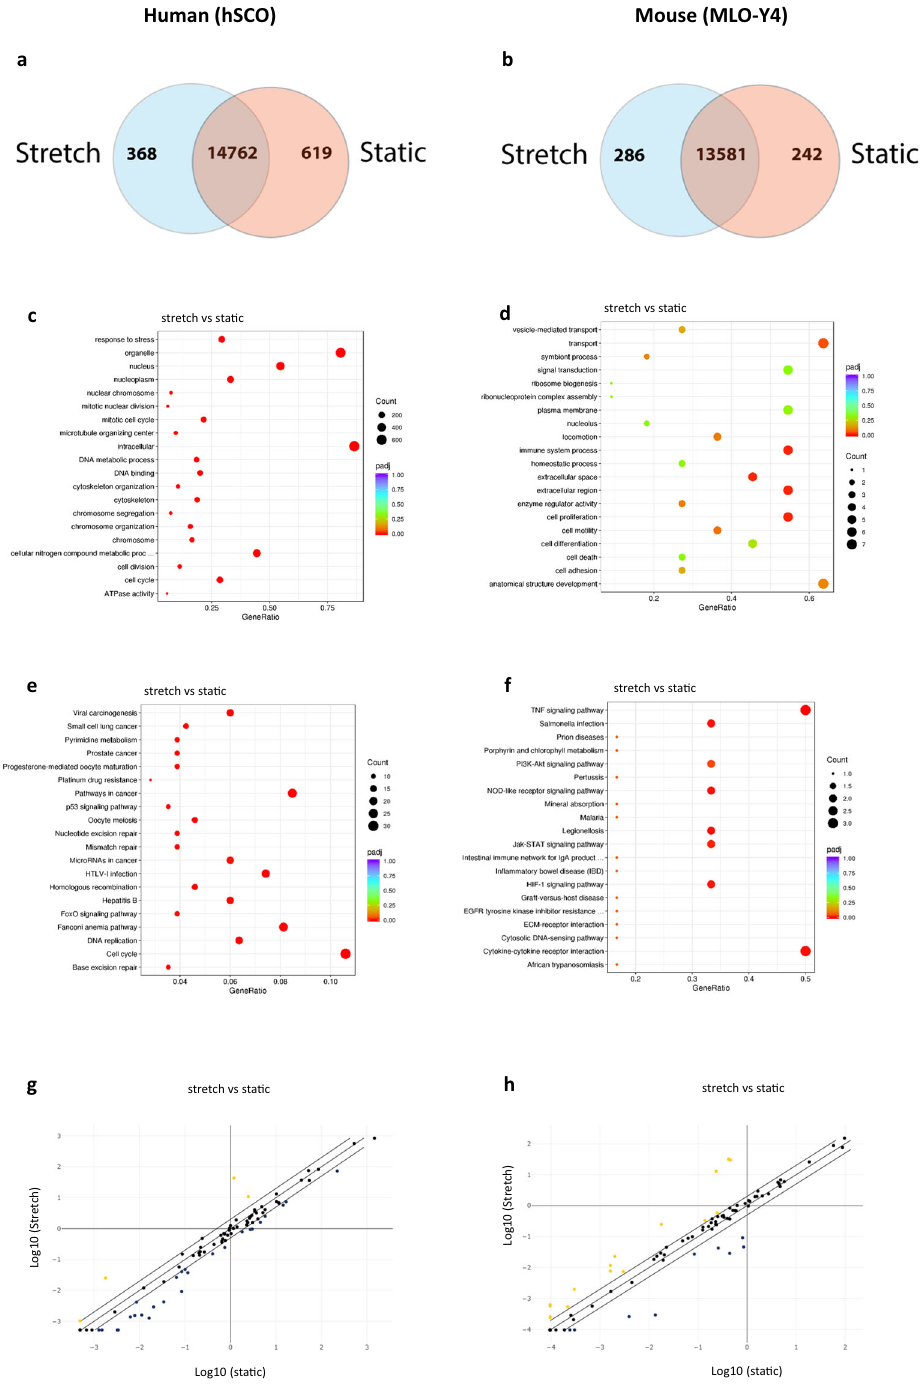
Fig. 1 Transcriptome analysis and WNT signalling in murine and human osteocytic cells. Venn diagram of hSCO ( a ) and MLO-Y4 ( b ) showing the gene transcripts exclusive to mechanically active and static cell culture conditions; Chart depicting top 20 overrepresented biological processes in hSCO ( c ) and MLO-Y4 ( d ) with red dots indicating statistical signi fi cance; Chart of top 20 overrepresented signalling pathways in hSCO ( e ) and MLO-Y4 ( f ) with red dots indicating statistical signi fi cance; scatter plot of genes belonging to the WNT signalling pathways in hSCO ( g ) and MLO-Y4 ( h ); Gene expression was nonsigni fi cant ( p > 0.05); n =